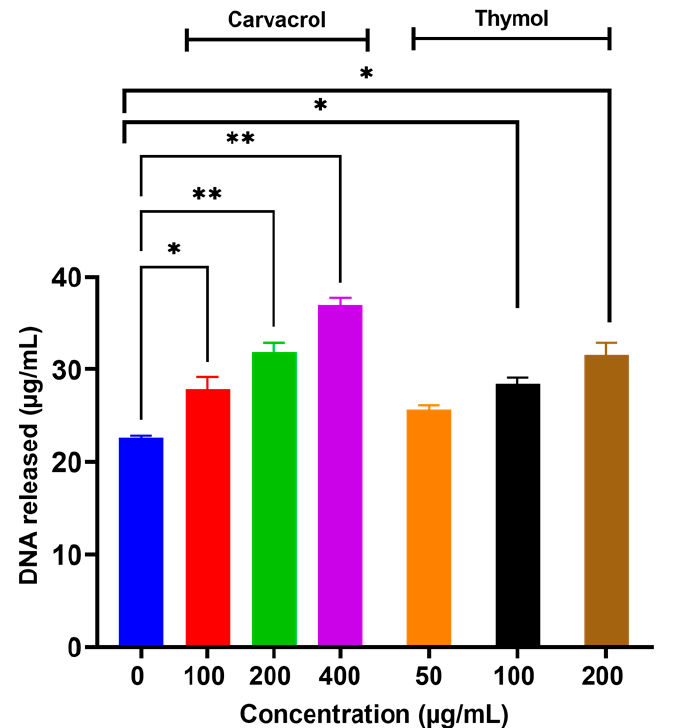
Figure 6. Release of the intracellular nucleic acid from desiccation-adapted Salmonella Tennessee E2007000304 when treated with different concentrations of carvacrol or thymol for 2.0 h at 37 °C. Each data point represents mean ± standard deviation. Asterisk (*) denotes significant difference at p < 0.05; and ** at p < 0.01.